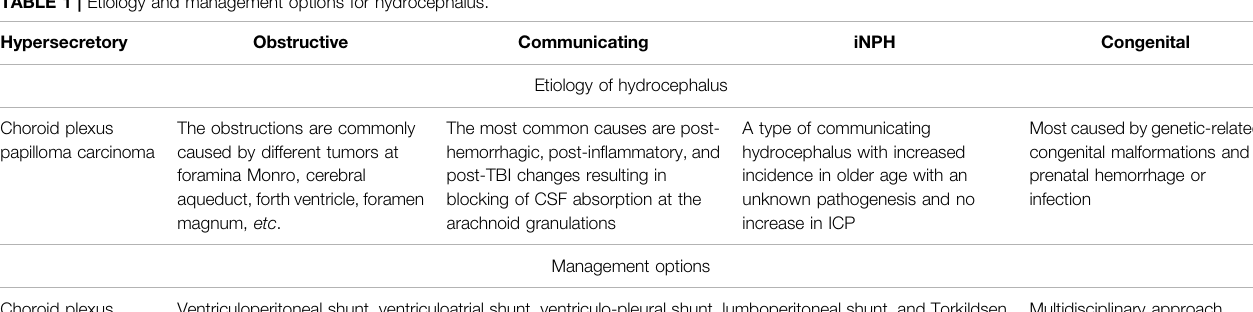
TABLE 1 | Etiology and management options for hydrocephalus. Hypersecretory Obstructive Communicating iNPH Congenital Etiology of